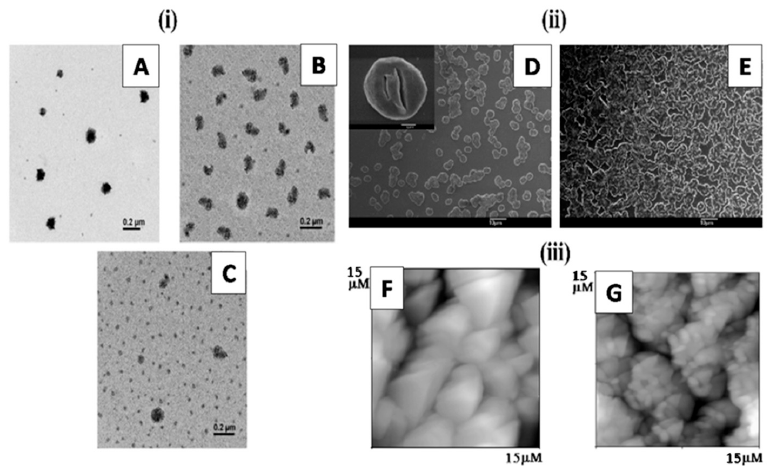
Figure 10. ( i ) TEM images of inulin without and with OTAB (octadecyl trimethyl ammonium bromide) are presented. ( ii ) FESEM demonstrations of the morphology change of inulin by the interaction with OTAB: ( D ) 0.5% ( w / v ) pure inulin; ( E ) with [OTAB] > C T . ( iii ) AFM images of pure inulin